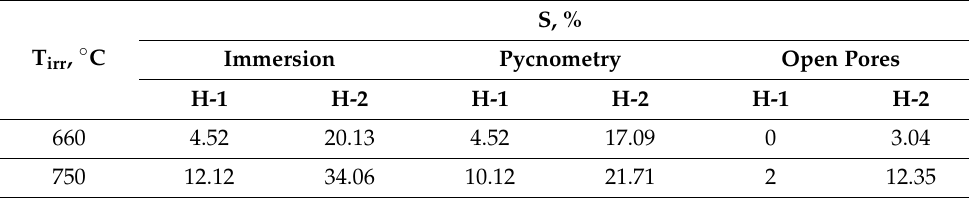
Table 3. Volume of open pores in irradiated cast Be. H-1—HIDOBE-01,